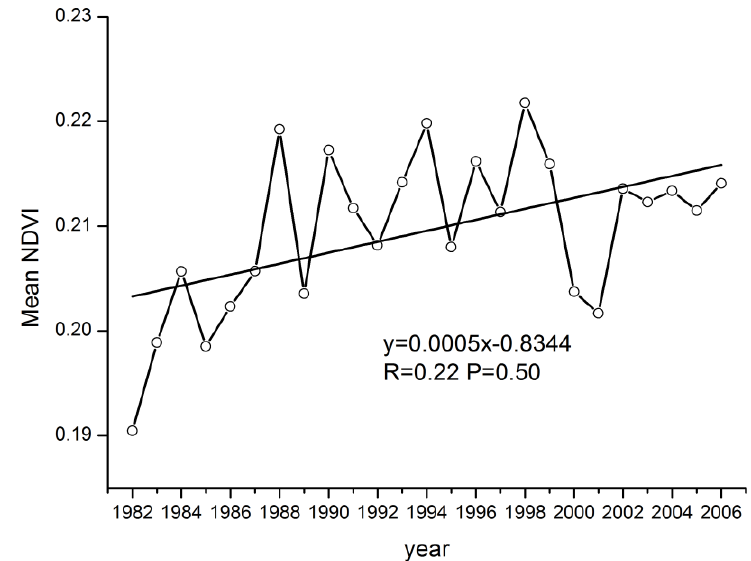
Figure 3. Inter-annual variations of the average NDVI in growth season from 1982–2006 in the TNSFP region.